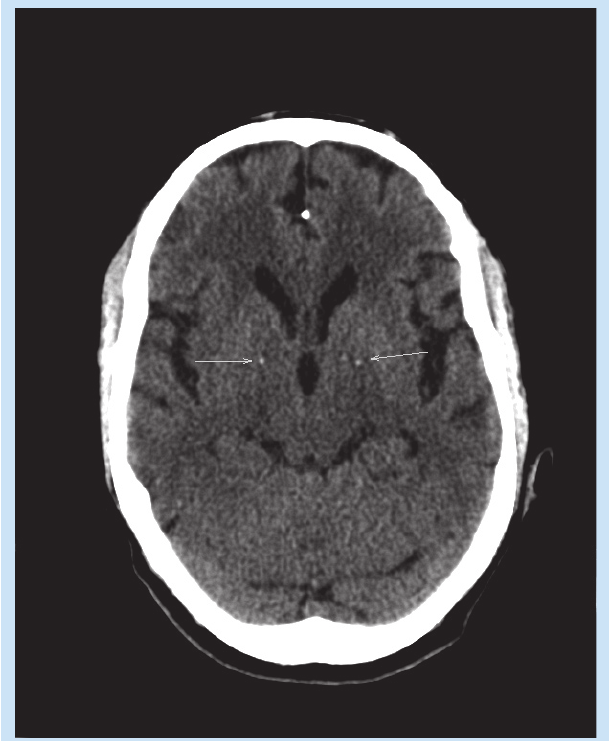
Fig. 1. Non-contrast CT scan of a 37-year-old male retroviral disease (RVD) positive patient showing basal ganglia calcification (arrows) and